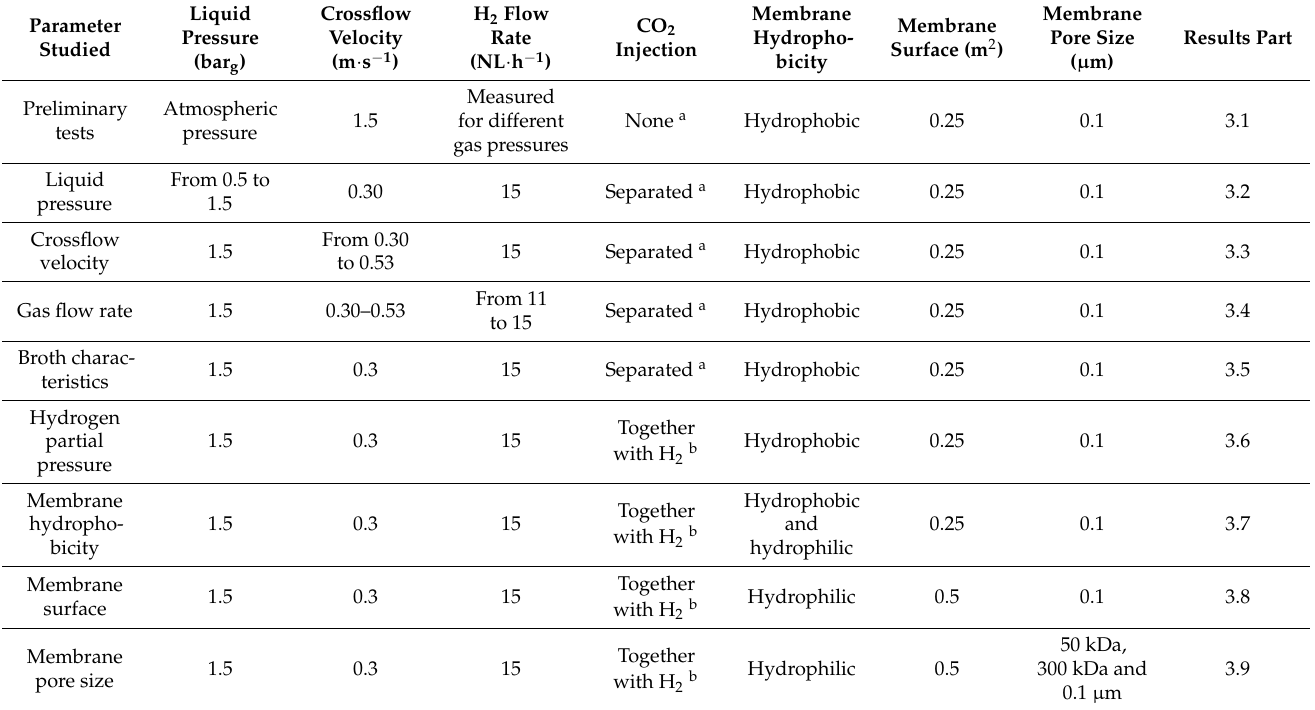
Table 1. Parameters applied in each